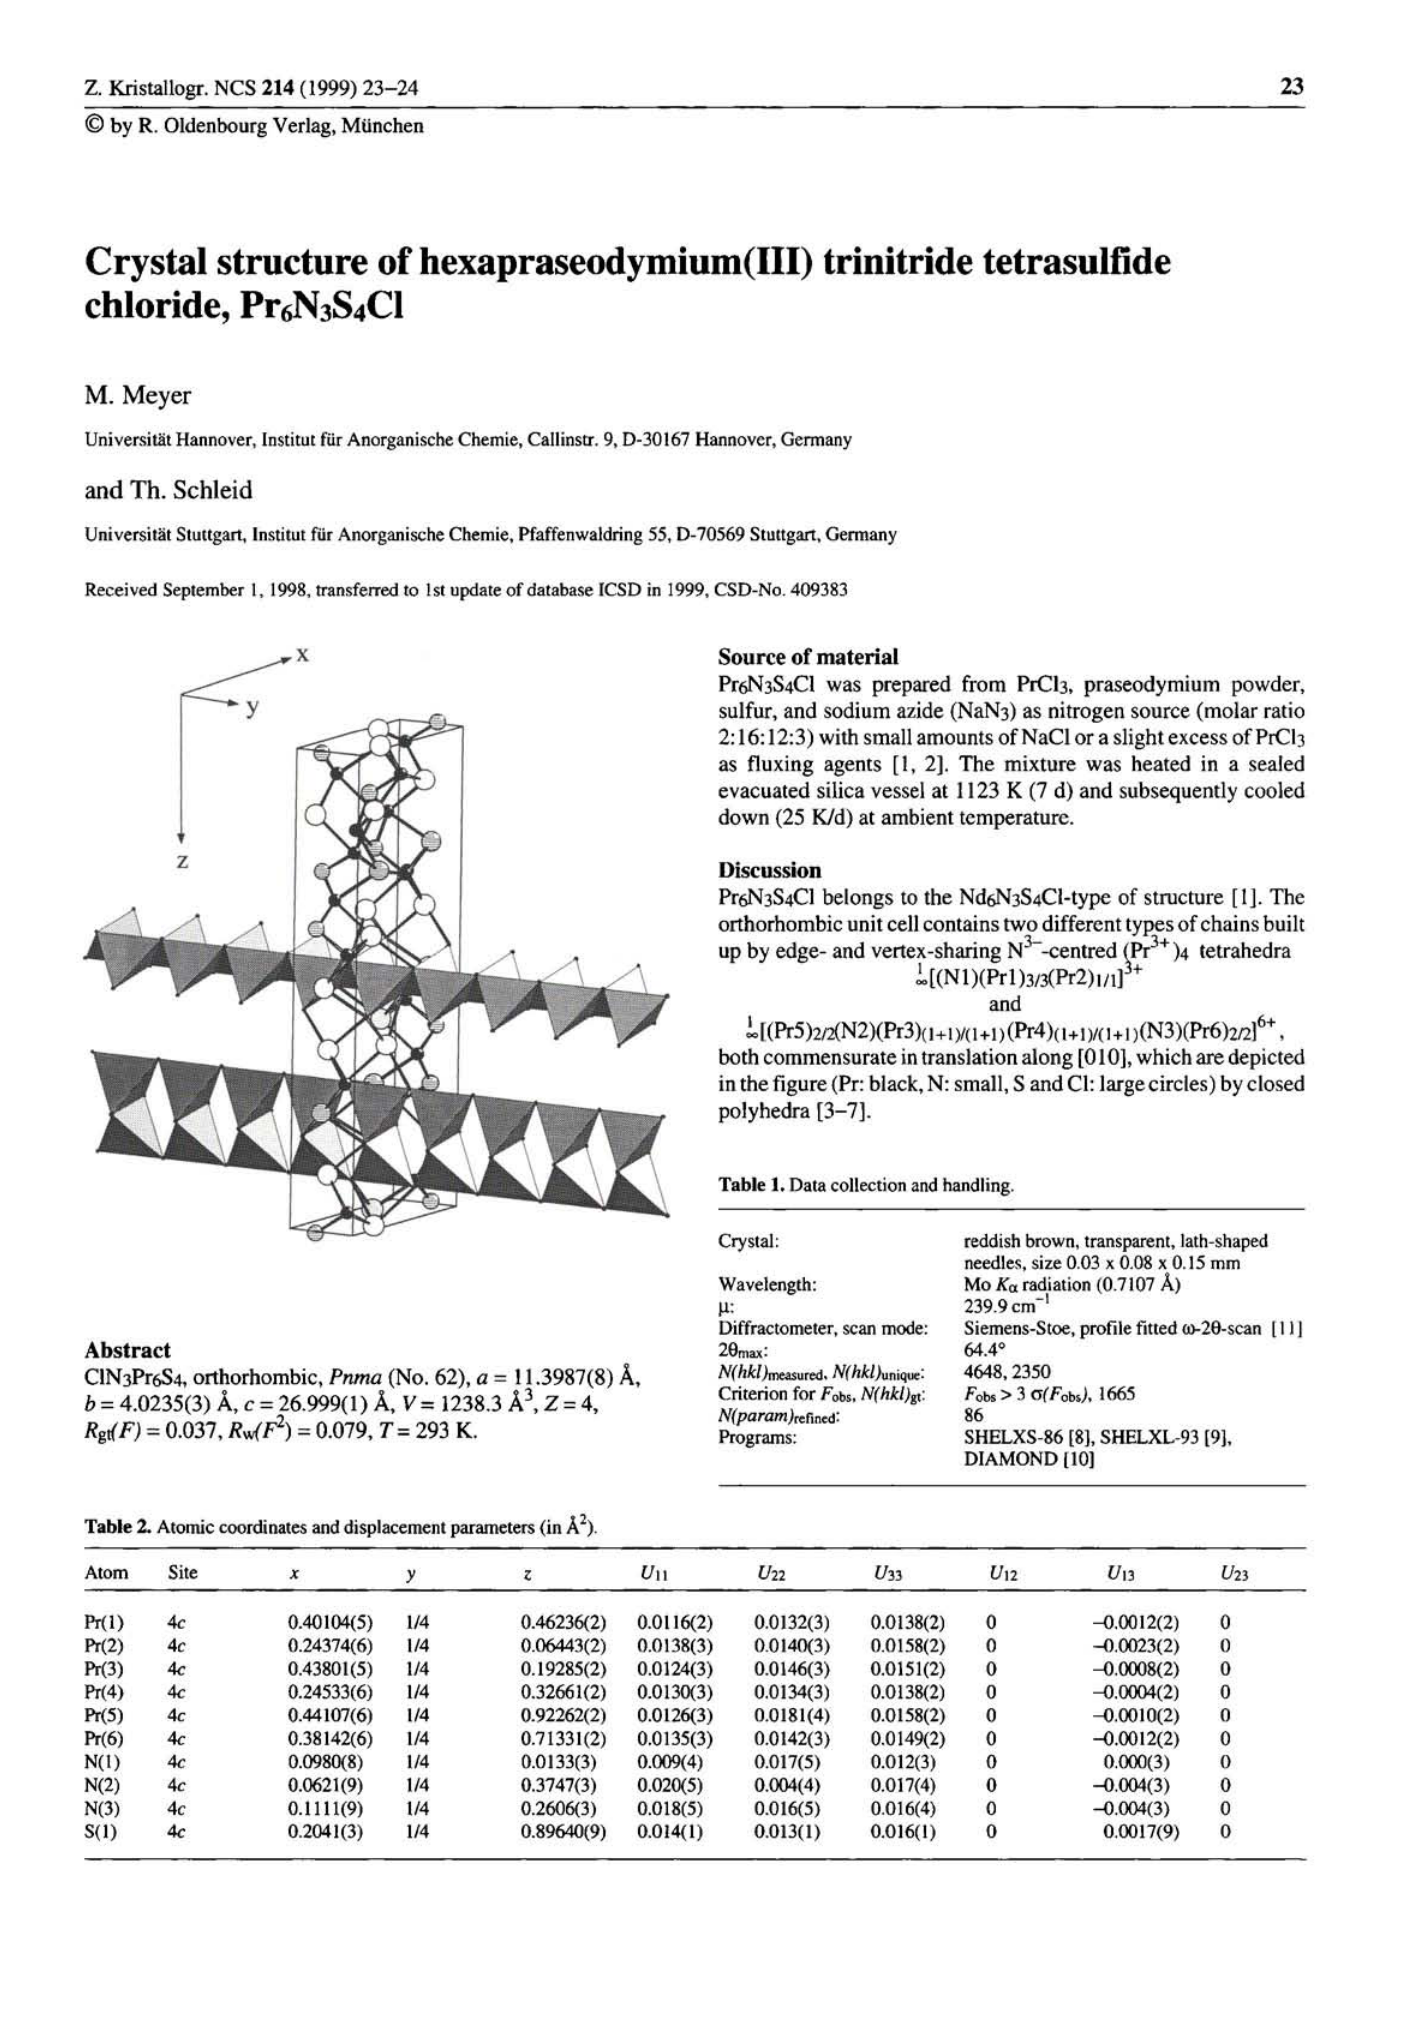
Table 2. Atomic coordinates and displacement parameters (in À 2